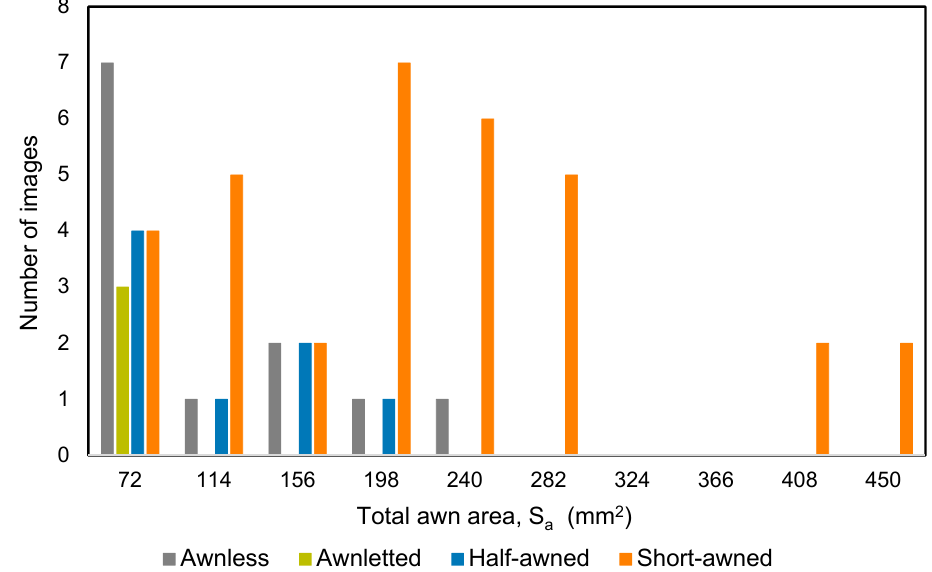
Figure 7. Histogram of the spike distribution according to awnedness type for the sample used to compute the total awn area.